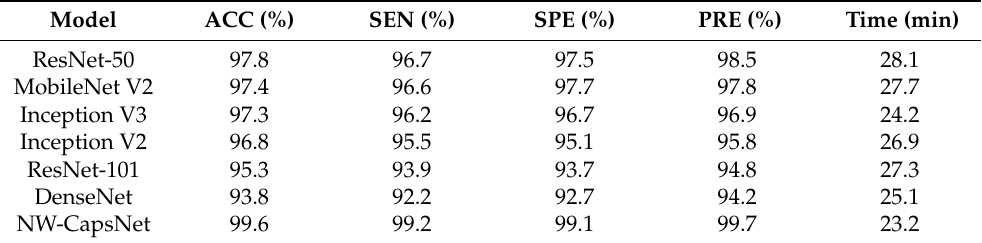
Table 3. Performance comparison of selected deep pre-trained models with the proposed model.